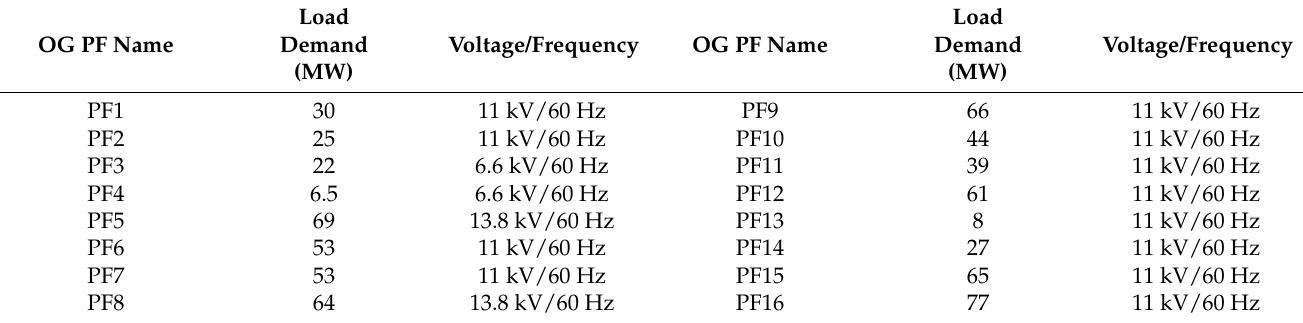
Table 4. Load demand and AC voltage rating for the utilised OG